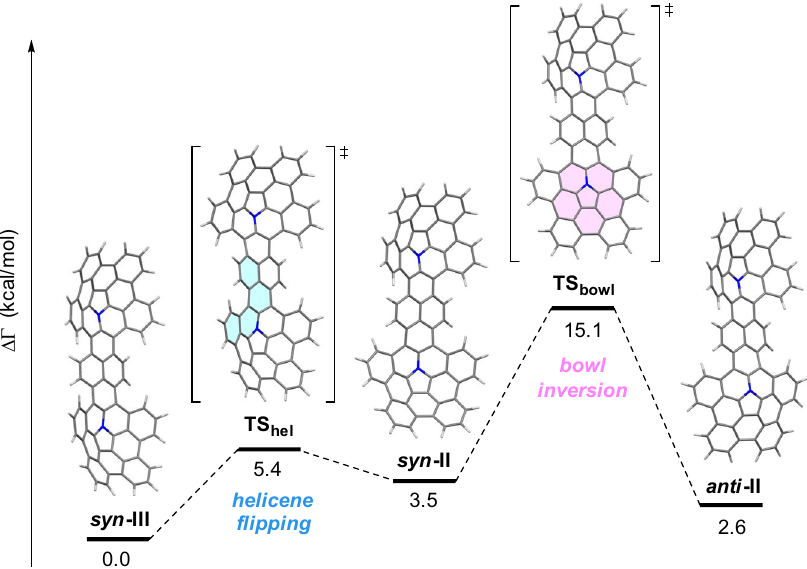
Fig. 4 Interconversion pathways of 4b calculated at the B3LYP/6-31G(d) level of theory. Blue highlights indicate a transition state that involves a helicene fl ipping of the [4]helicene moiety, while pink highlights indicate a transition state that involves a bowl inversion of the azacorannulene